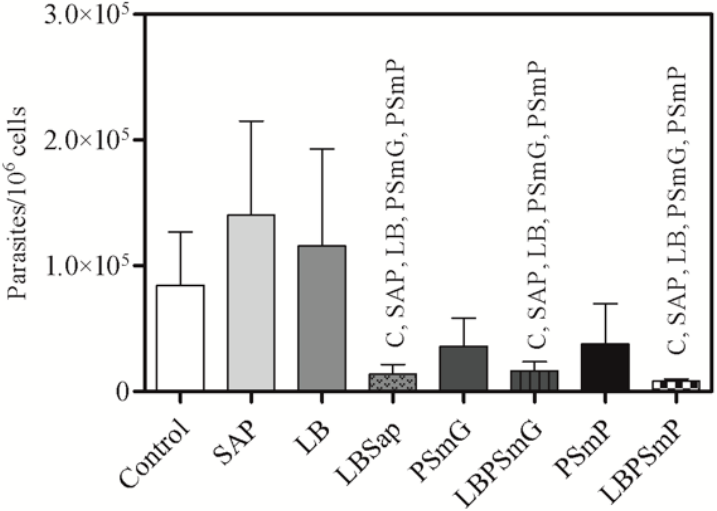
Figure 5. Parasite load in spleen after experimental challenge obtained from q PCR reaction. The results represent the log scale of parasite burden quantification in the spleen. The x axis represents the experimental groups and the y axis represents the mean and standard deviation of parasite quantification in 10 6 splenocytes. Statistical differences ( p < 0.05, Mann–Whitney) between groups were indicated by acronyms in the correlated group(s). LEGEND: C—Control (white bar); Sap—Saponin (light gray bar); LB— L. braziliensis antigen (medium gray bar); LBSap— L. braziliensis antigen plus saponin (dot medium gray bar); PSmG—Empty submicrometric large particle (dark gray bar); LBPSmG—Submicrometric large particle plus Leishmania braziliensis antigen (vertical line dark gray bar); PSmP—Empty submicrometric small particle (black bar); LBPSmP—Submicrometric small particle plus Leishmania braziliensis antigen (checkered